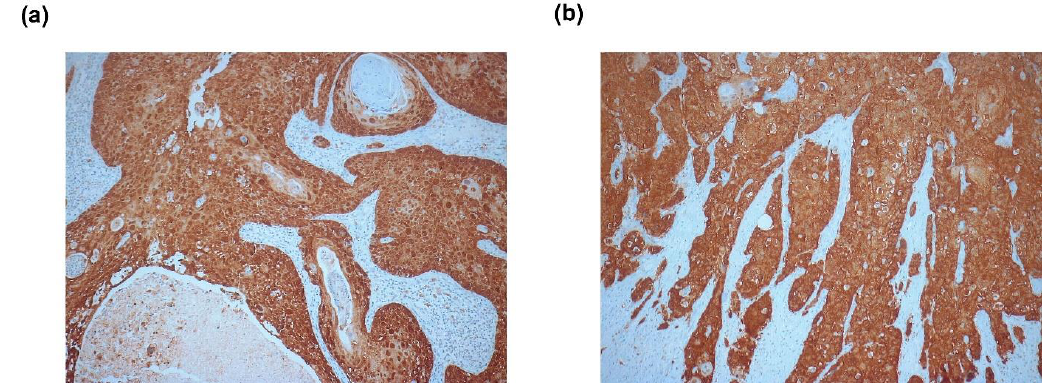
Figure 1. Representative images of positive p16 staining of two anal squamous cell carcinoma (SCC) samples. The tumors harbored ( a ) human papillomavirus-16 (HPV16) and ( b ) multiple HPV subtypes (HPV16 and HPV73), according to the PCR-based HPV array analysis. 100× magnification.